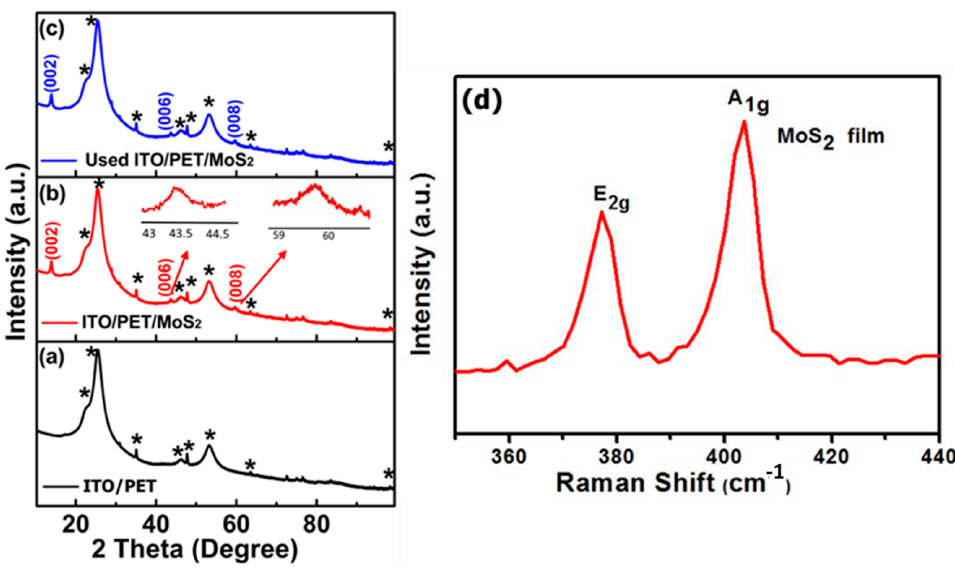
Figure 2. XRD pattern of: ( a ) ITO/PET substrate showing its characteristic peaks and labeled with Asterisk, ( b ) 2D MoS 2 NSs film, ( c ) XRD after using the catalyst, 2D MoS 2 Nanosheets, and ( d ) Raman for PET/ITO/MoS 2.